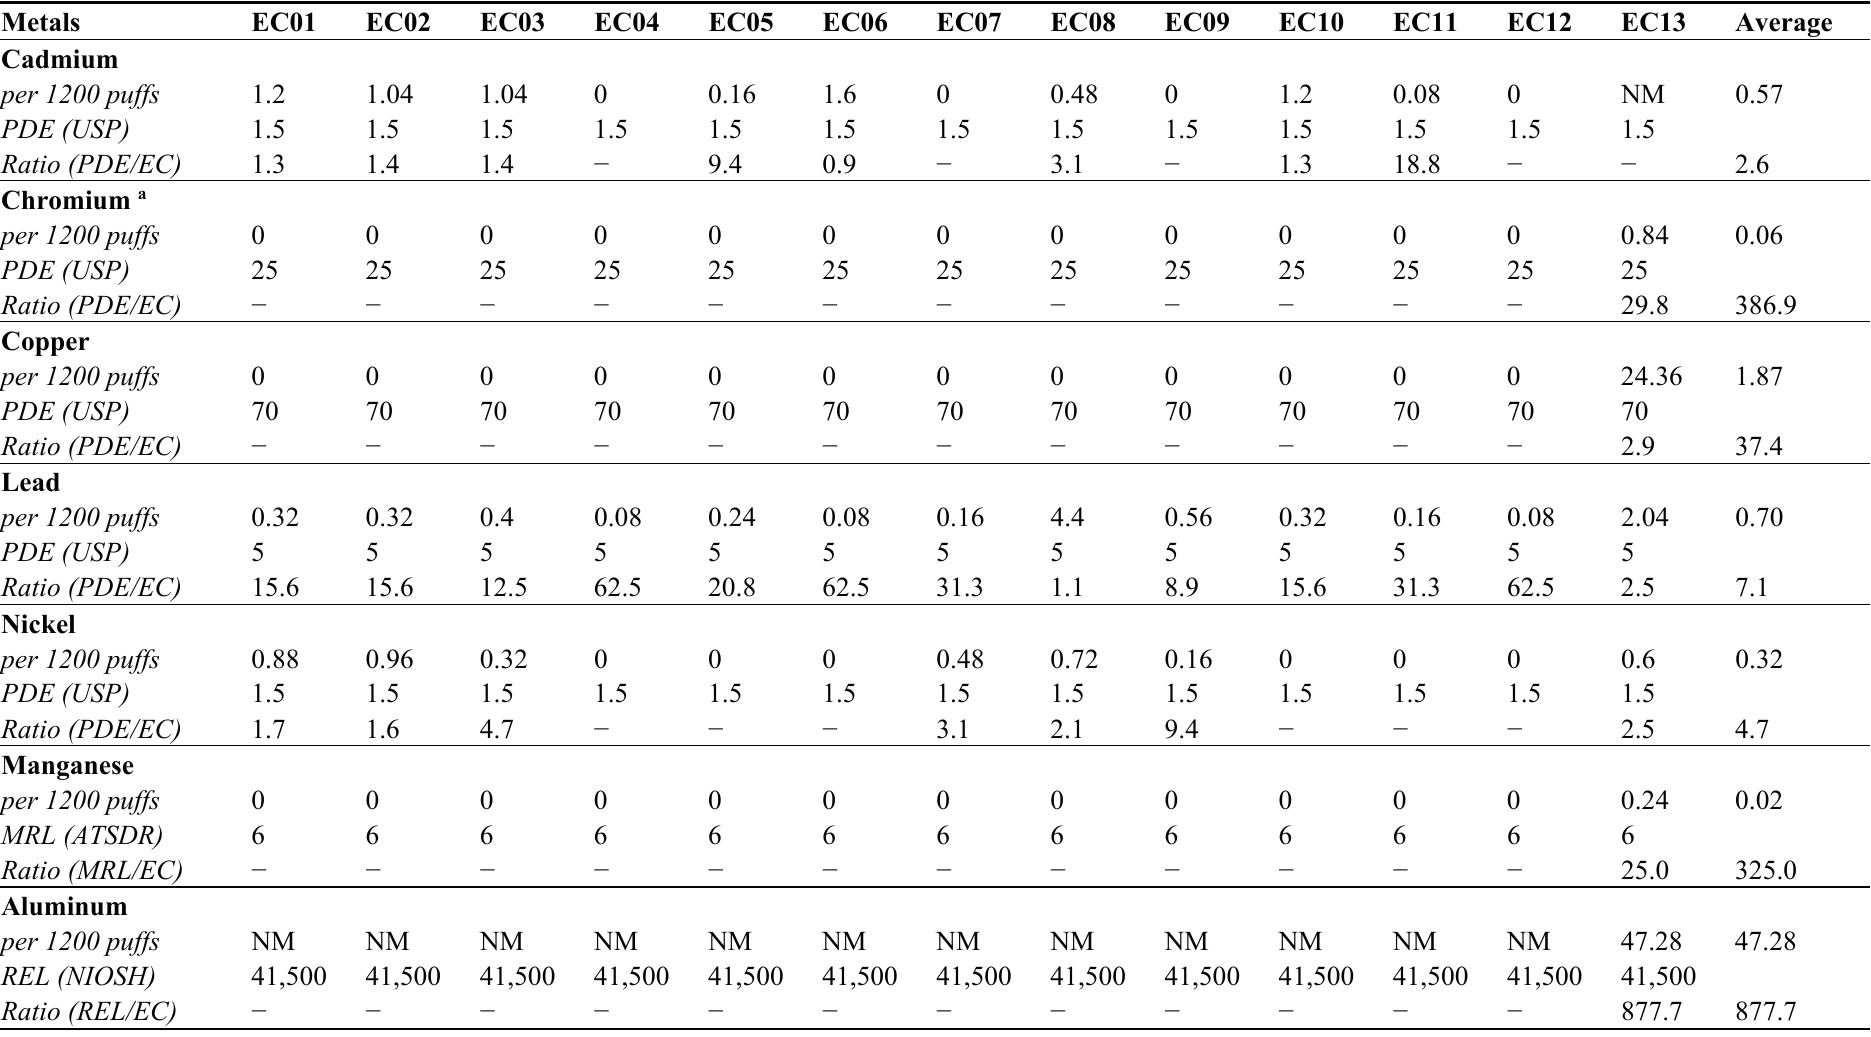
Table 1. Exposure to metals from electronic cigarette use in comparison with regulatory safety limits from the primary analysis (assuming 20 m 3 and 8.3 m 3 respiratory volumes in 24-h and 10-h respectively); all values are in μ